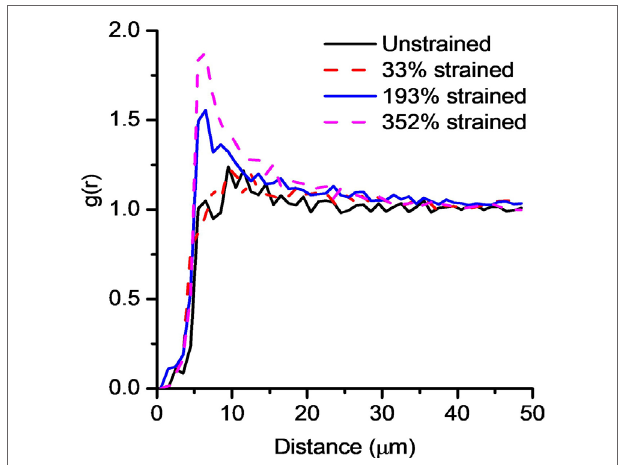
FigUre 6 | Pair correlation function for thick segments ( > 3.7 μ m) for the unstrained fiber mat and fiber mats strained to 33, 193, and